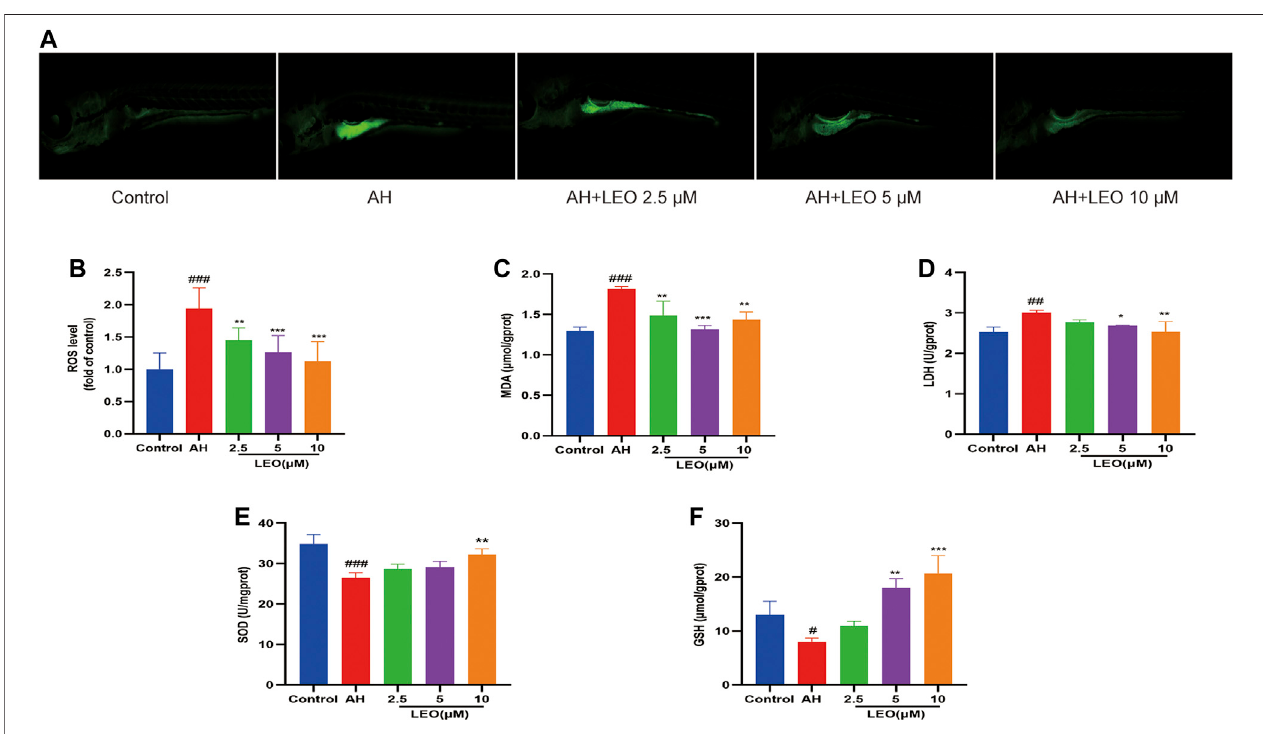
FIGURE 6 | Effect of LEO on NO and ET-1 levels in zebra fi sh treated with AH. (A) NO level, (B) ET-1 level. Values are presented as means ± SD ( n (cid:1) 3). # p < 0.05, ## p < 0.01 , ### p < 0.001 vs Control group; * p < 0.05 , ** p < 0.01, *** p < 0.001 vs AH group.